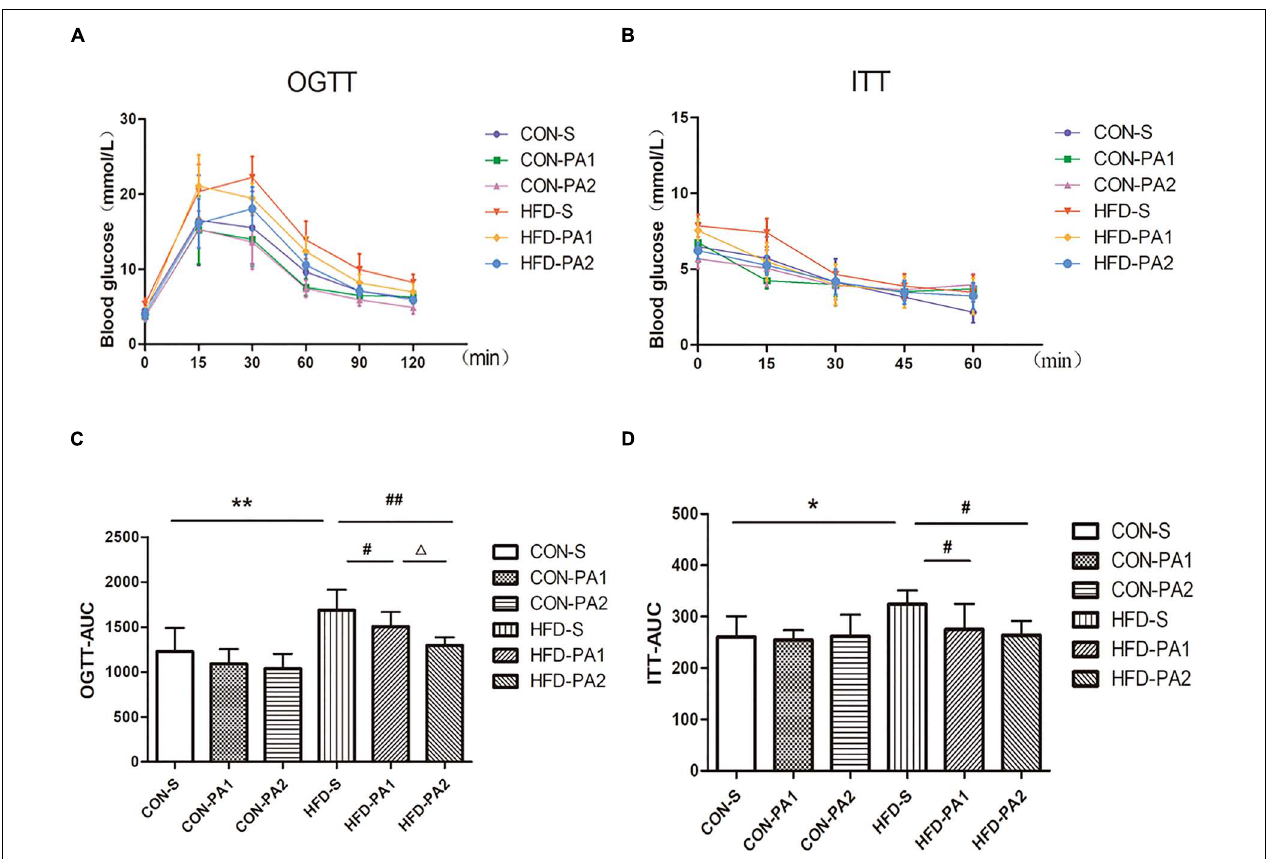
FIGURE 3 | Glucose change curves of OGTT and ITT. (A,C) OGTT in mice after fasting for 12 h. Histograms represent the areas under the glucose curve. (B,D) ITT in mice after fasting for 2 h. Histograms represent the areas under the glucose curve. Compared with the CON-S group, * P < 0.05 and ** P < 0.01; compared with the HFD-S group, # P < 0.05 and ## P < 0.01; comparison between exercise groups (CON-PA1 vs. CON-PA2 and HFD-PA1 vs. HFD-PA2), (cid:49) P < 0.05 and (cid:49)(cid:49) P <